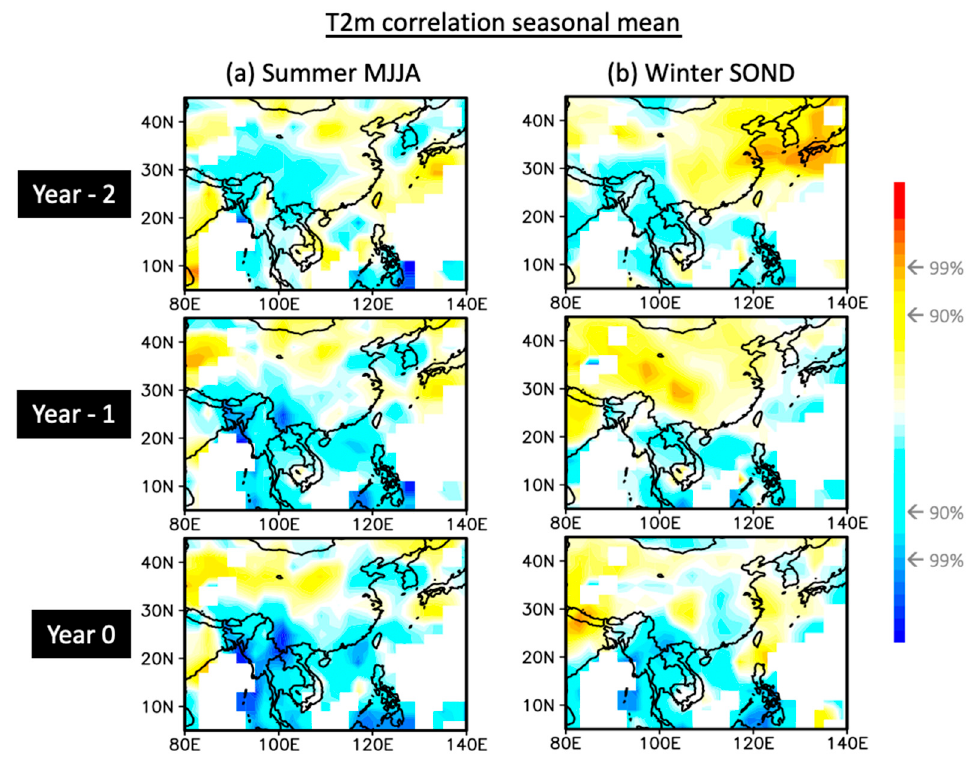
Figure 4. One-point correlation maps of the 2-m air temperature with the Pest Index for the ( a ) summer (May–August) and ( b ) winter (September–December), with the air temperature shifted from (top to down) two years ago to the current year. The color bar indicates the significance levels. In the winter, the Indochina temperature variation during the years leading up to the current year is not as consistent as in the summer. Still, the Philippines remain cooler during the high-pest years, suggesting an enhanced monsoon system in either season [19].